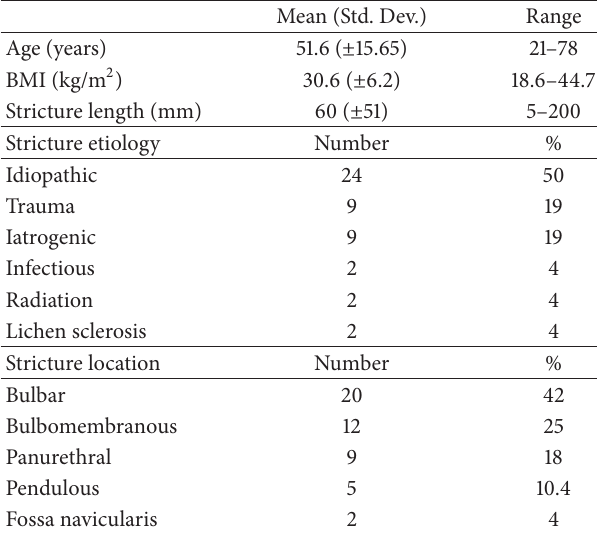
Table 1: Patient characteristics.